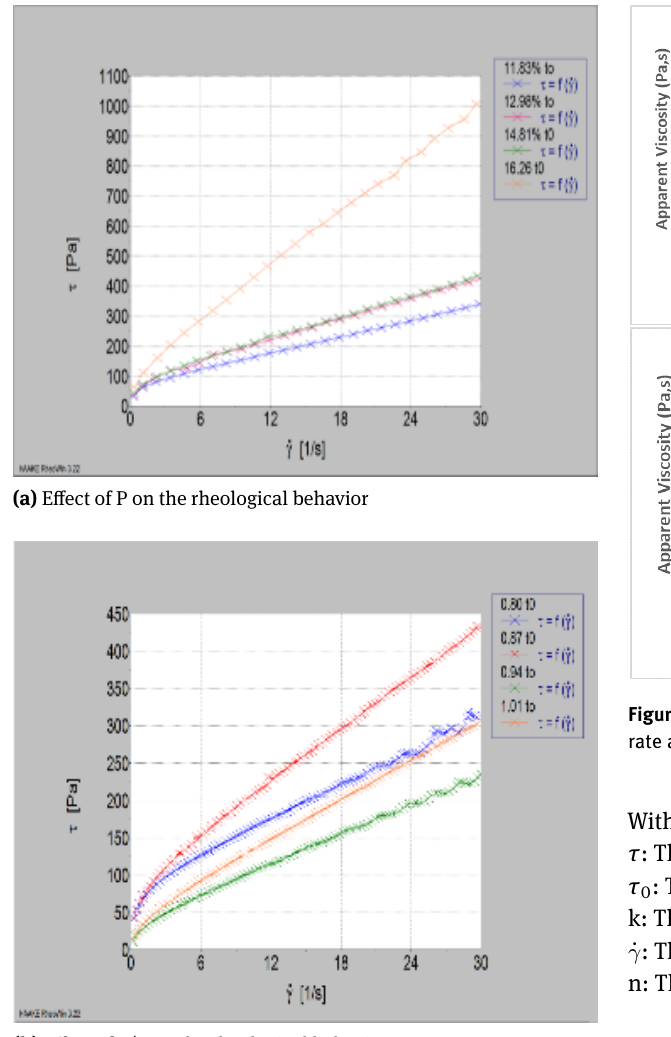
Figure 7: Rheograms of the different formulations considered